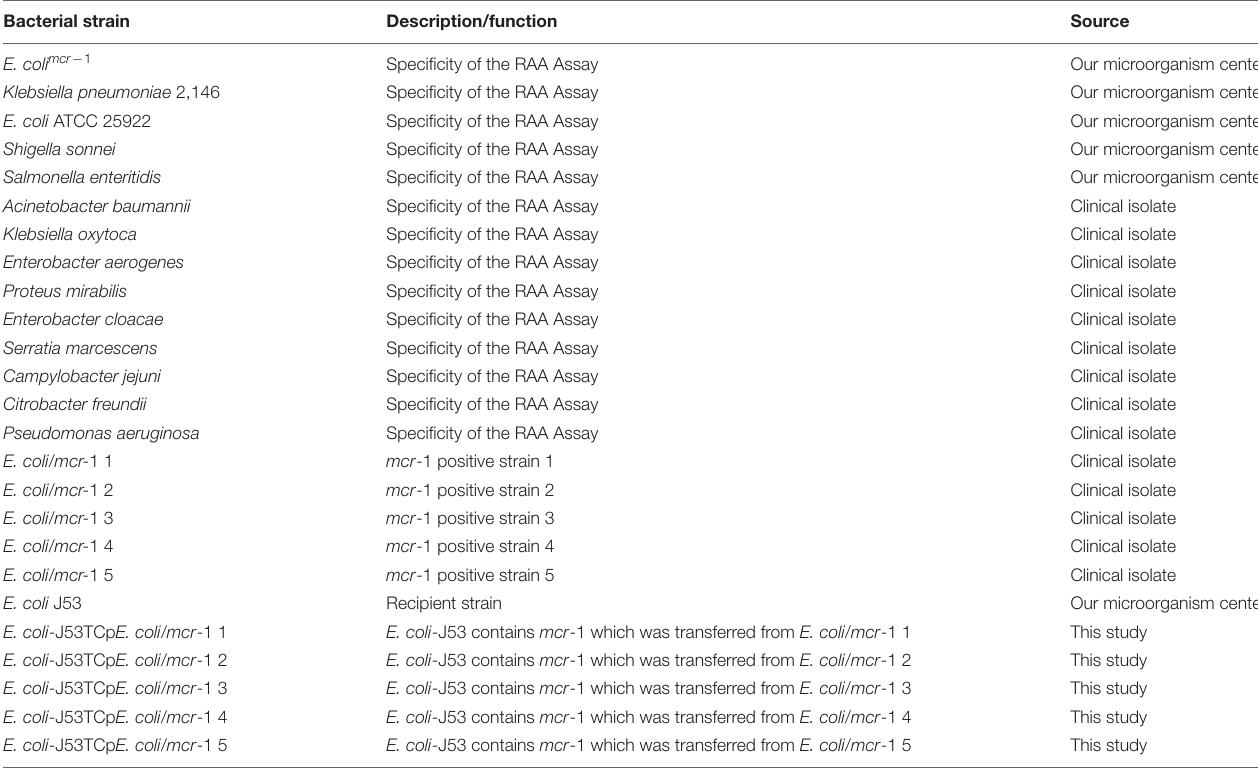
TABLE 1 | Bacterial strains used in this